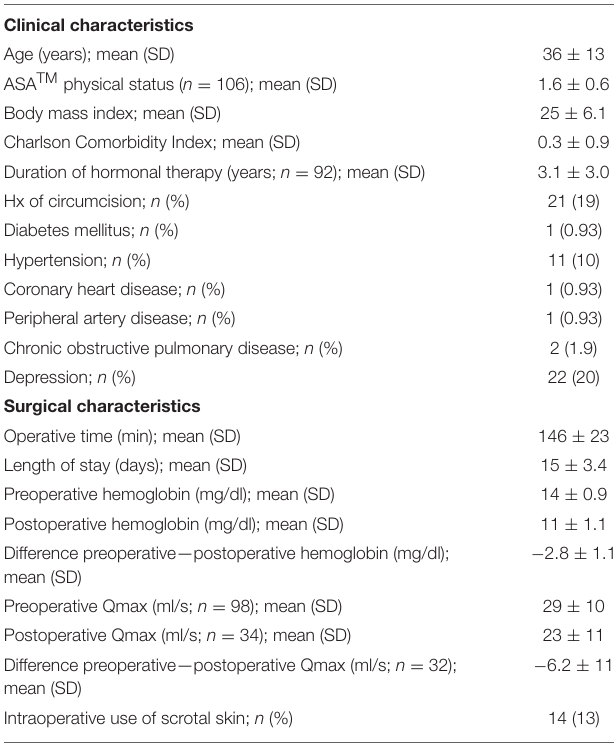
TABLE 1 | Clinical and surgical characteristics of 108 transgender women undergoing penoscrotal flap inversion vaginoplasty between 2015 and 2018. Clinical